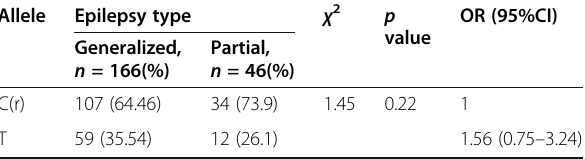
Table 7 Association between MDR1 C3435T allele and